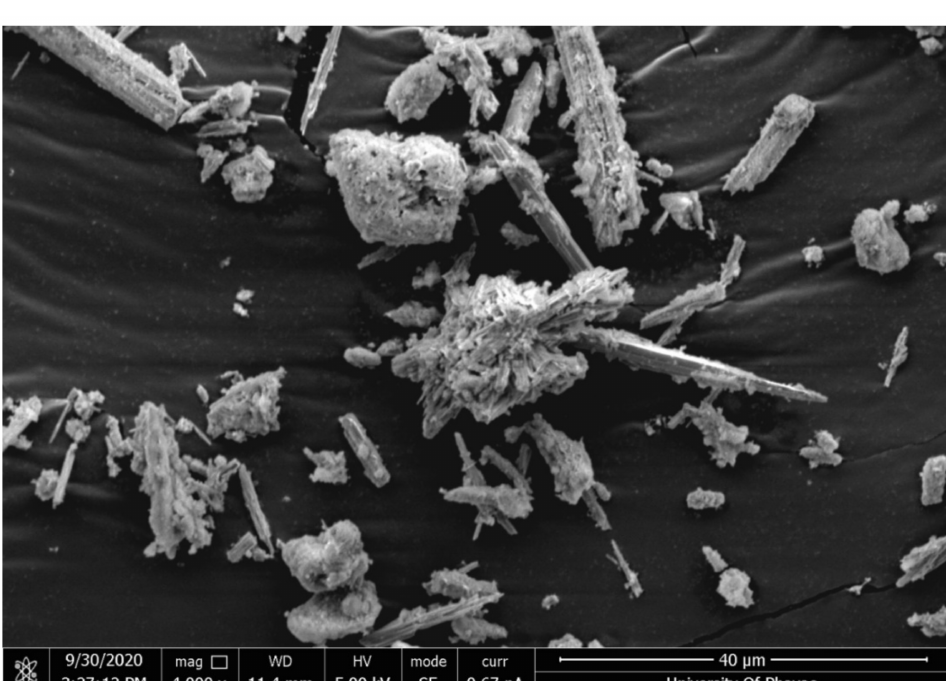
Figure 2. Phusang waterfall powder at 180 ◦